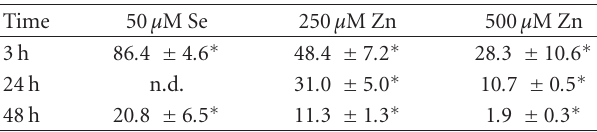
Table 3: E ff ects of high concentrations of Zn 2+ and selenite on the uncoupled respiration of AS-30D cells. The rate of uncoupled respiration (in the presence of CCCP) of control cells is accepted as